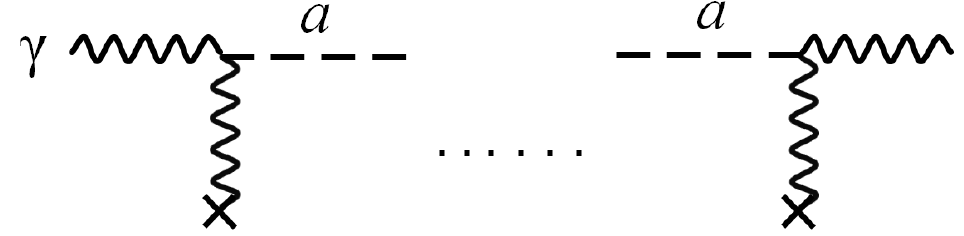
Figure 3. Schematic view of a γ ↔ a oscillation in the external magnetic field B